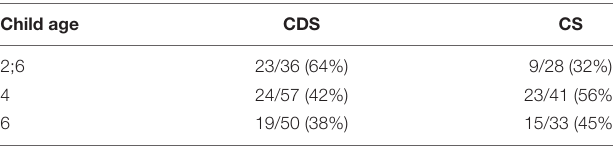
TABLE 3 | Number and proportion of vocalic intrusions in produced clusters in CDS and CS by age of the child.